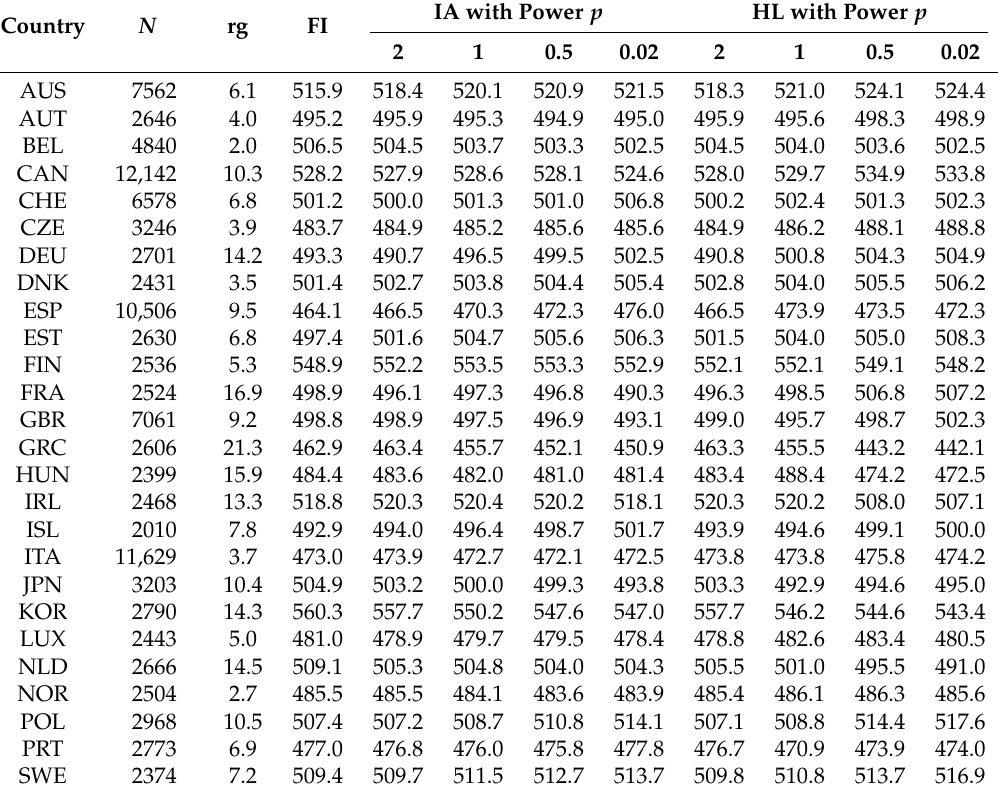
IA with Power p